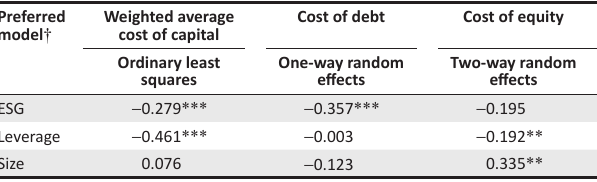
TABLE 3: Regression results for the composite environmental, social and corporate governance disclosure scores for the consumer goods sector. Preferred Weighted average model † cost of capital